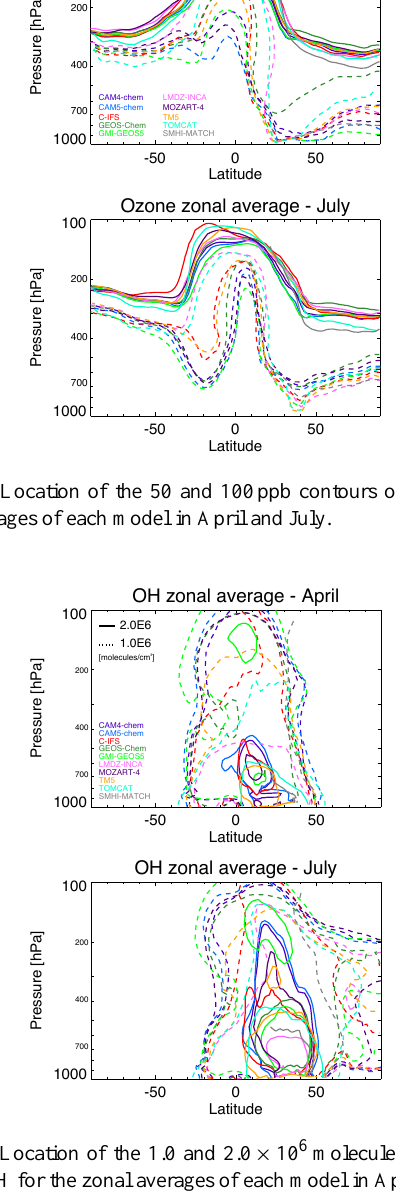
values above 2 × 10 6 moleculescm − 3 in the northern tropics from the surface to 500 hPa. GMI is the only model to show a maximum greater than 2 × 10 6 moleculescm − 3 also in the upper troposphere. About half of the models have OH con-